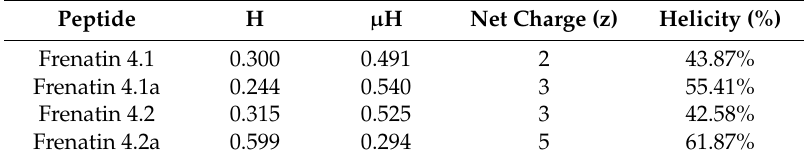
H represents hydrophobicity and μ H represents hydrophobic moment.